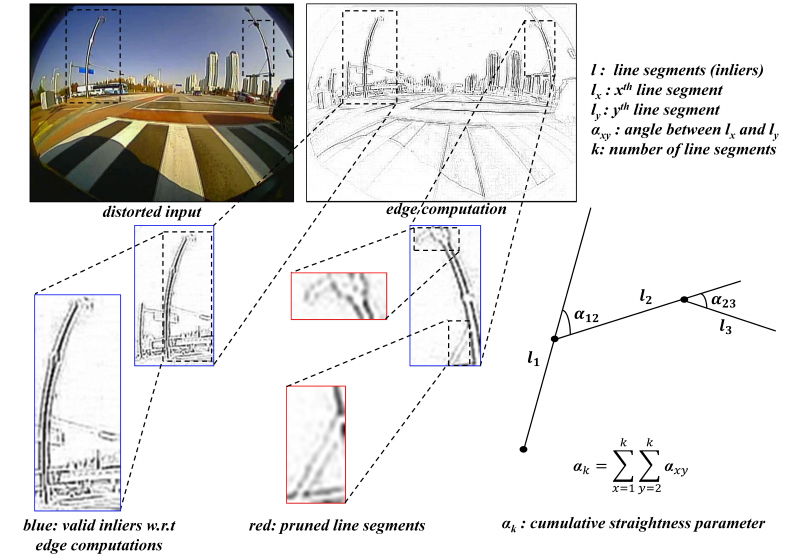
Figure 5. Pre-processing of line candidates and Estimation of Straightness